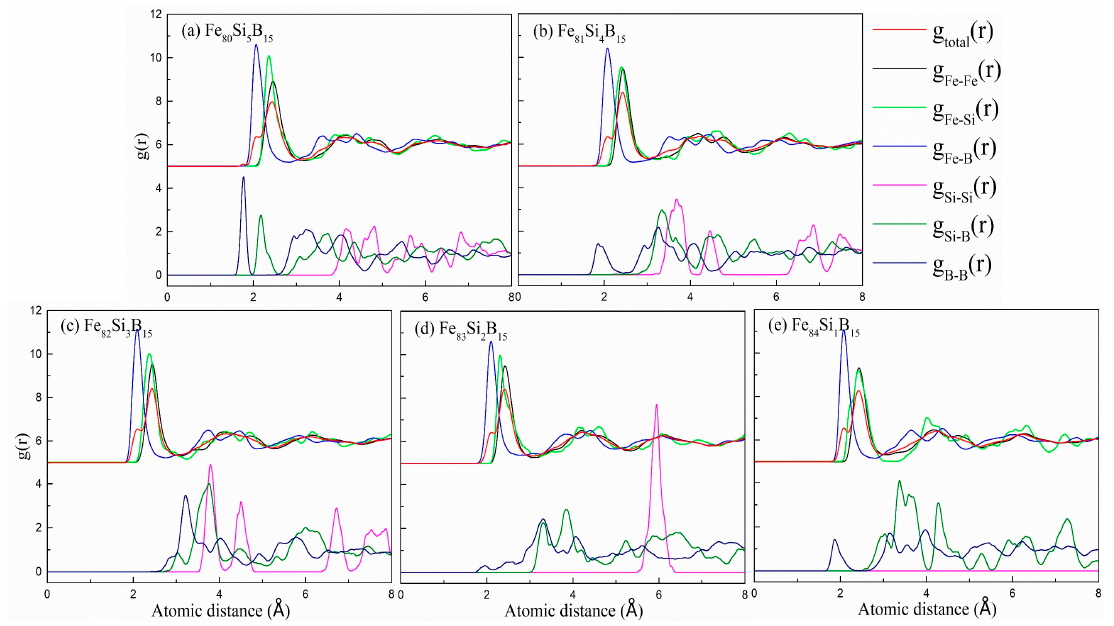
Figure 1. Total and partial PDFs of the Fe 80+x Si 5 − x B 15 ( x = 0–4) amorphous alloys at 300 K. ( a ) Fe 80 Si 5 B 15 ,